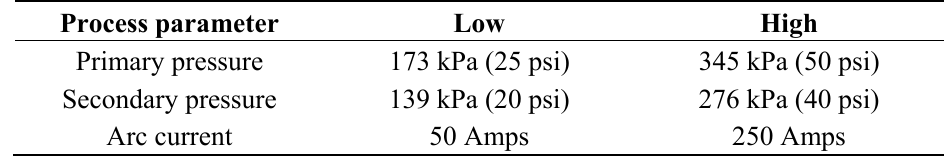
Table 1. Torch operating condition